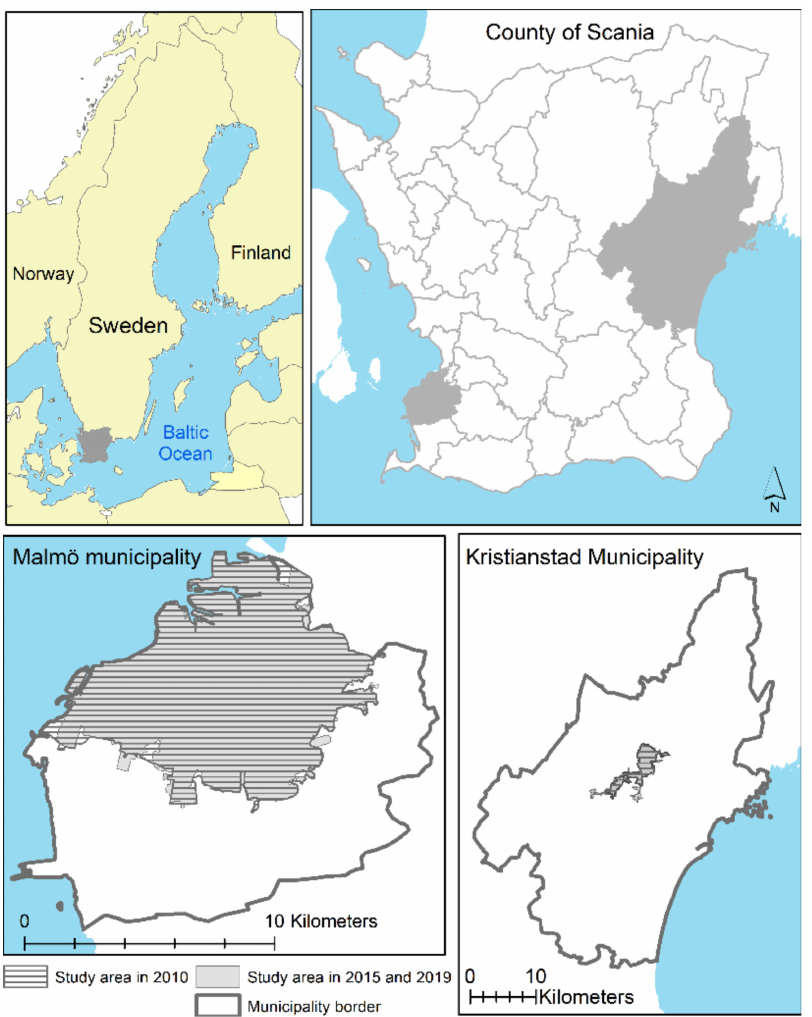
Figure 1. Overview map of location of the county of Scania in Sweden (upper left), the municipalities Malmö and Kristianstad location in Scania (upper right) and study areas in Malmö (lower left) and Kristianstad (lower right) for the three